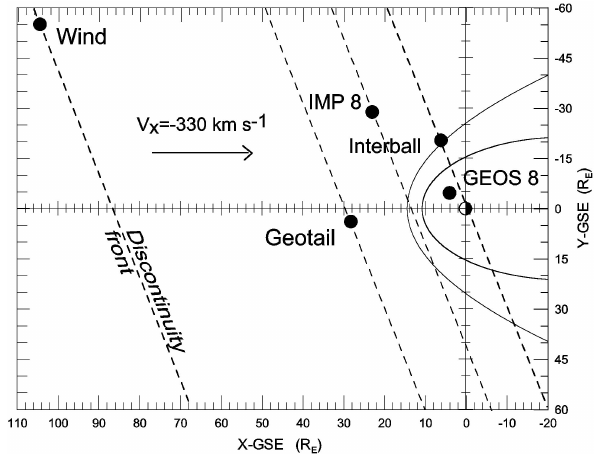
Fig. 10. The solar wind pressure discontinuity front that occurred on 7 August 1997, swept progressively the Wind, Geotail, IMP-8, GEOS-8 and Interball sites moving earthward. The satellite posi- tions are shown projected on the ecliptic plane.